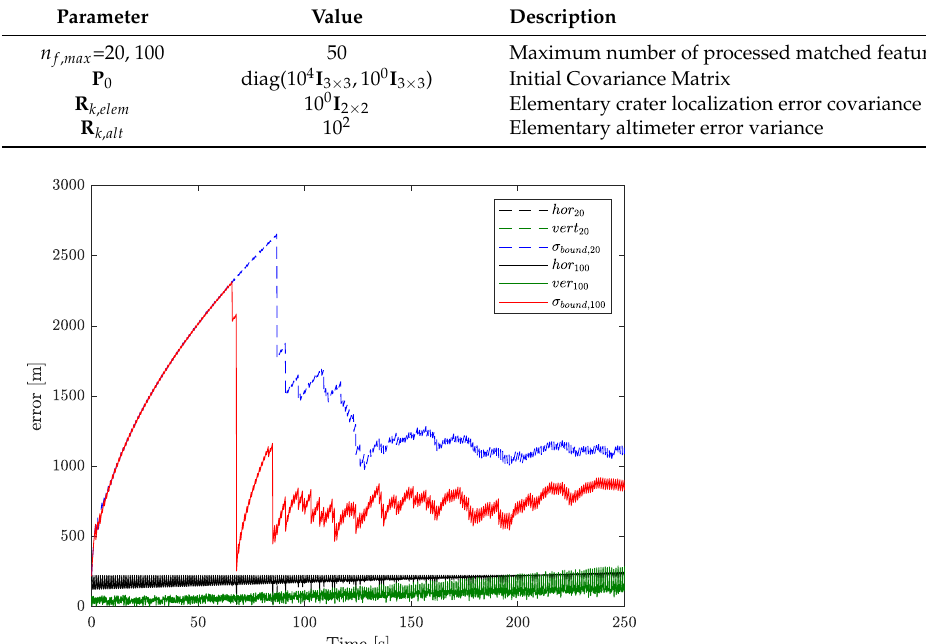
Table 1. Simulation parameters.